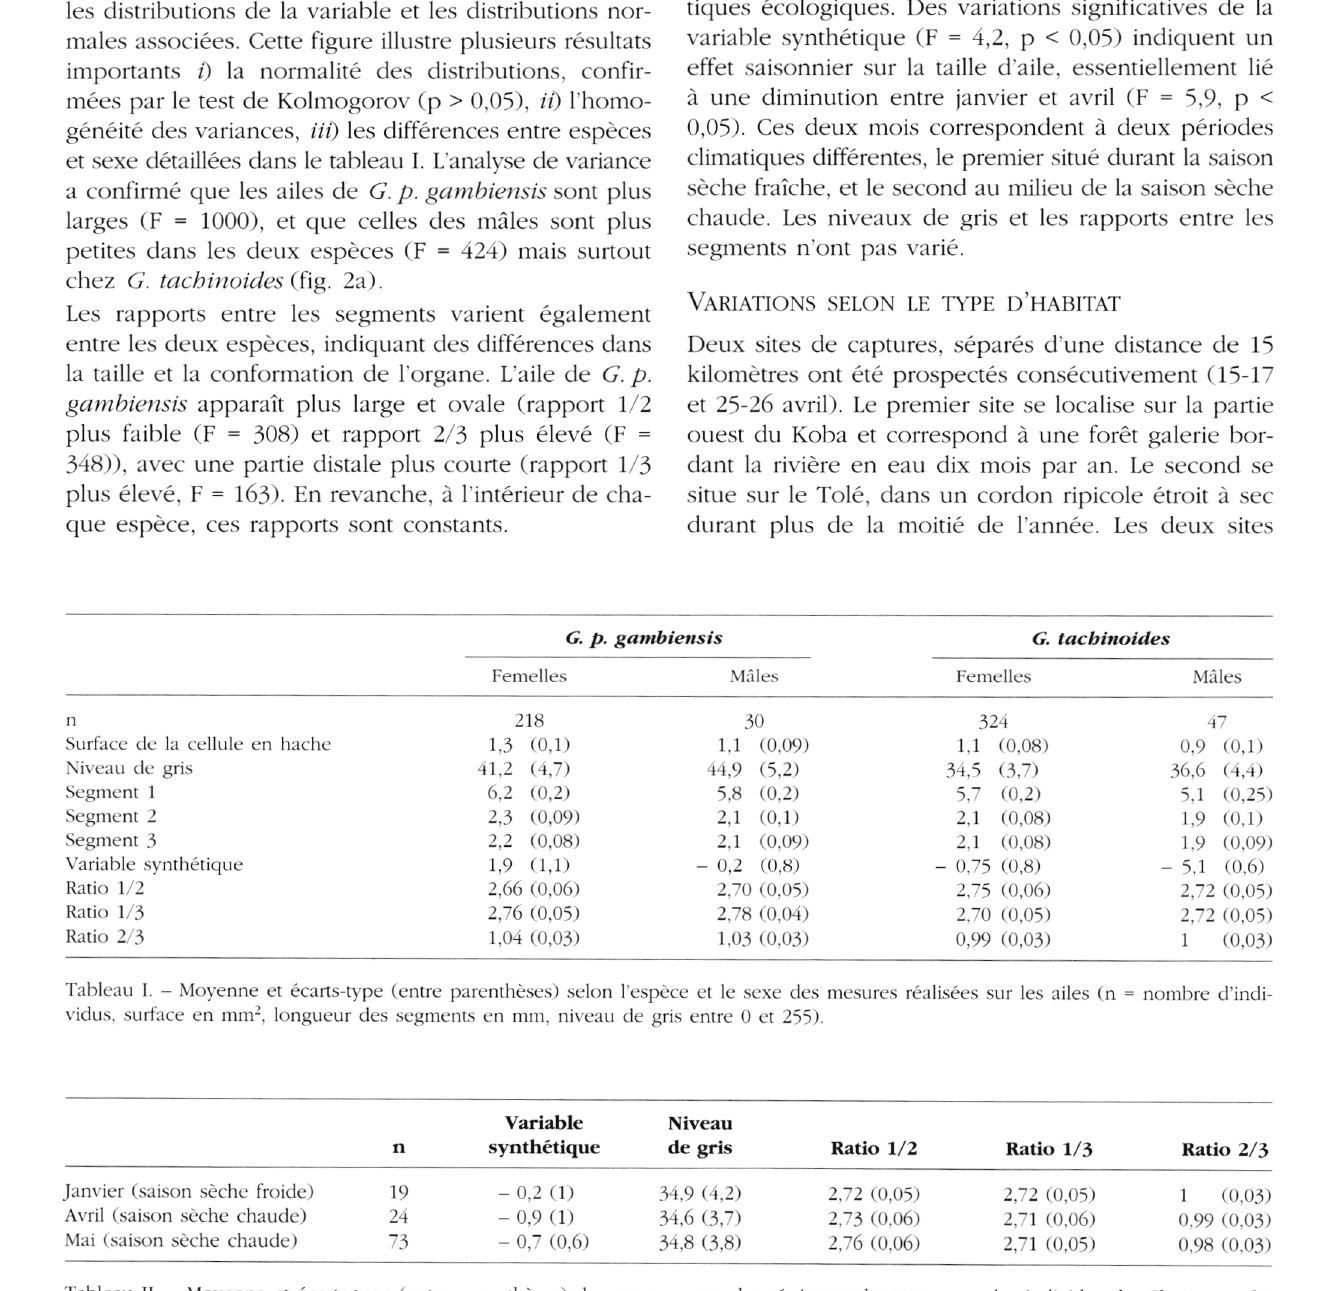
Tableau II. - Moyenne et écarts-type (entre parenthèses) des mesures morphométriques obtenues avec des individus de Glossina tachi­ noides femelles capturées à différentes dates dans la zone de Sidéradougou (n = nombre d’individus, surface en mm2, niveau de gris entre 0 et